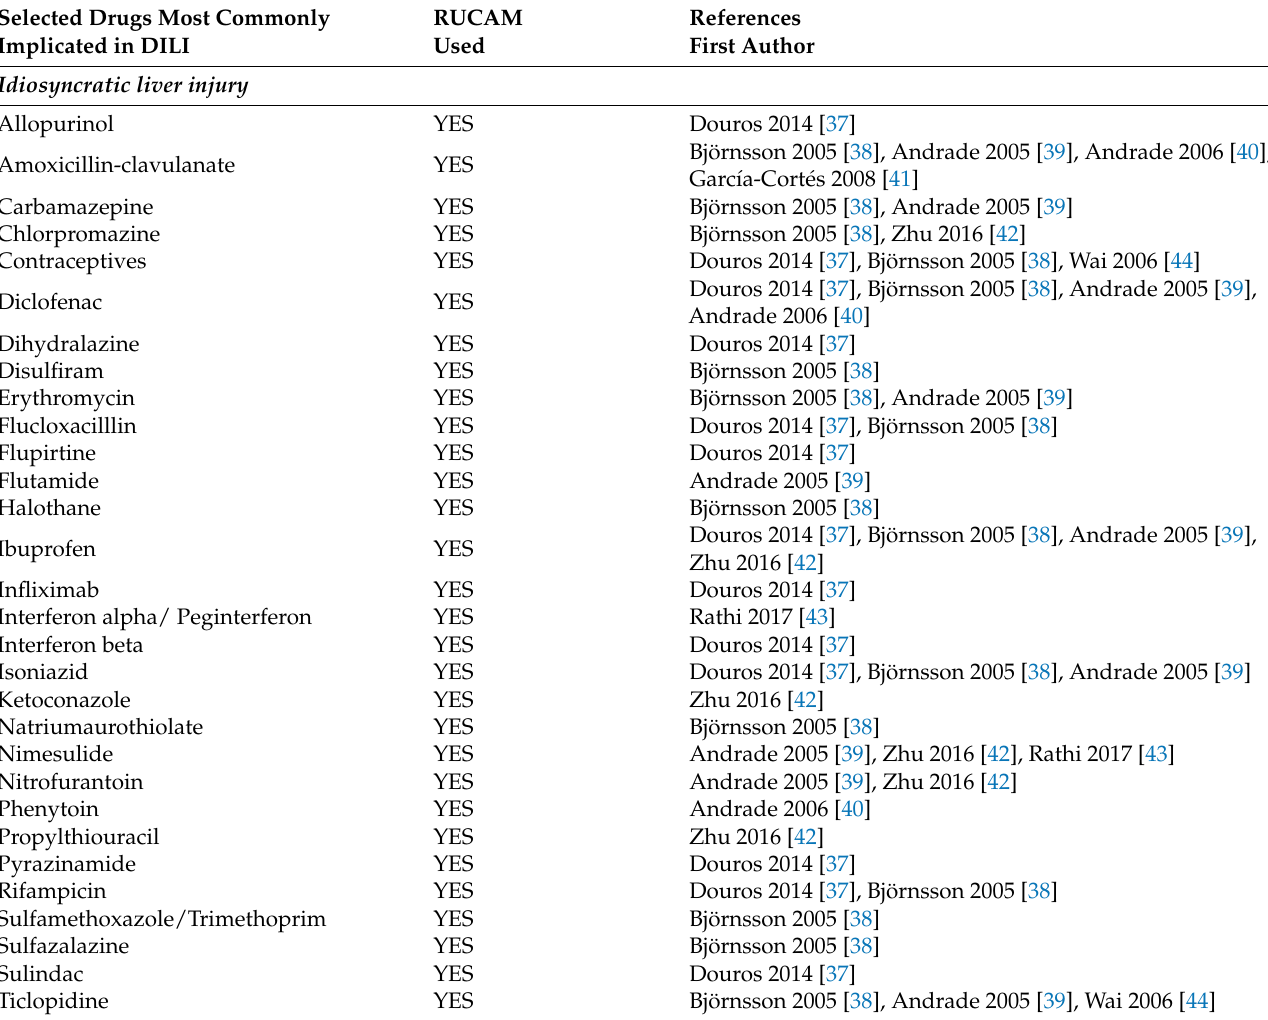
Table 1. Selected drugs most implicated in idiosyncratic and intrinsic